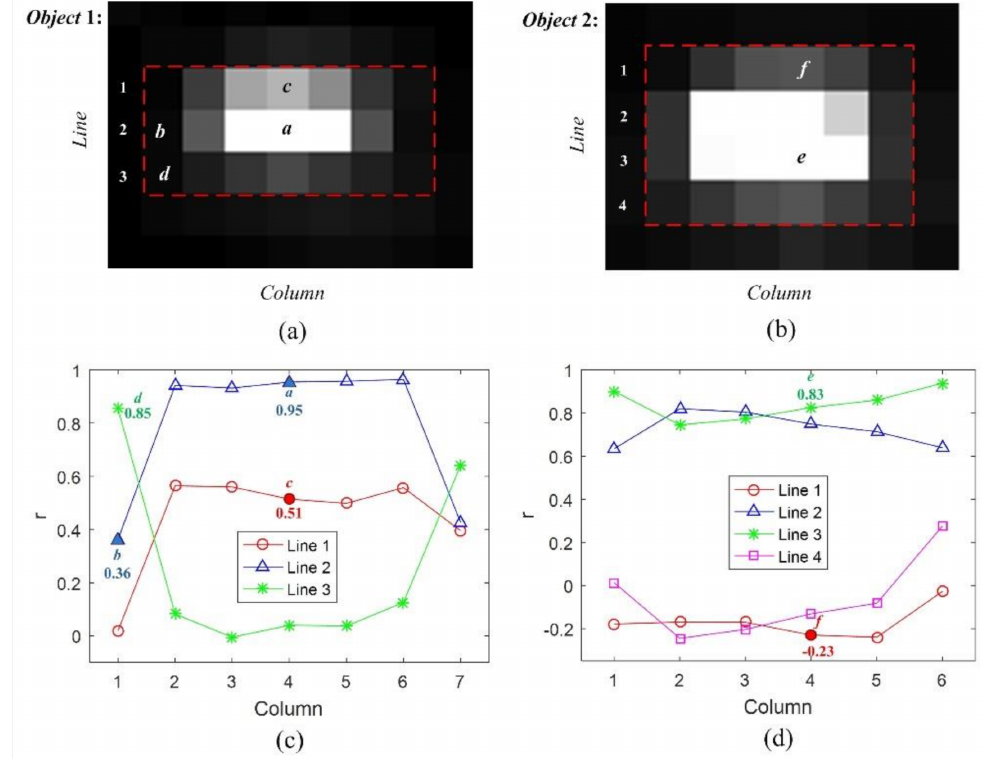
Figure 2. Two types of object streaks and correlation coefficients between data and models in different positions (pixel a: center of Ob 1, pixel b: image background 1, pixel c: longitudinal edge of Ob 1, pixel d: image background 2, pixel e: center of Ob 2, pixel f: longitudinal edge of Ob 2). ( a ) Ob 1. ( b ) Ob 2. ( c ) Correlation coefficients of Ob 1. ( d ) Correlation coefficients of Ob